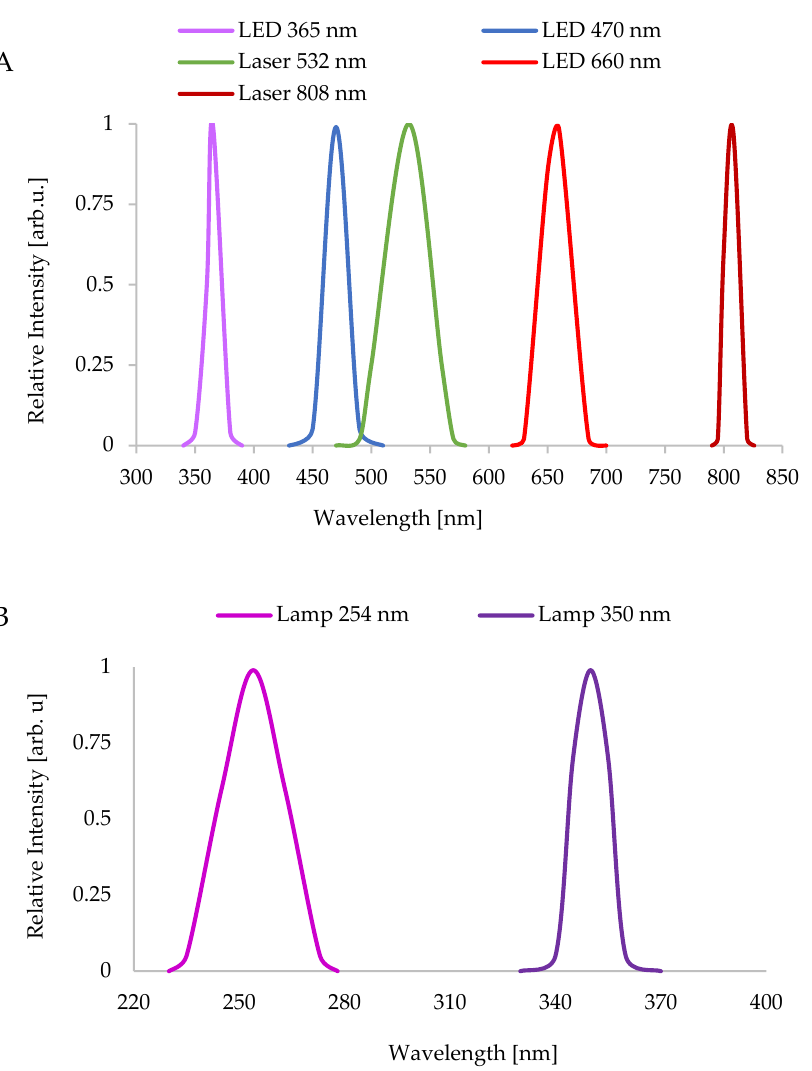
Figure 1. The wavelength spectrum and the maximum wavelength value of the employed light sources. ( A ) the spectra of the used LEDs and lasers; ( B ) the spectra of the used broadband UV lamps.